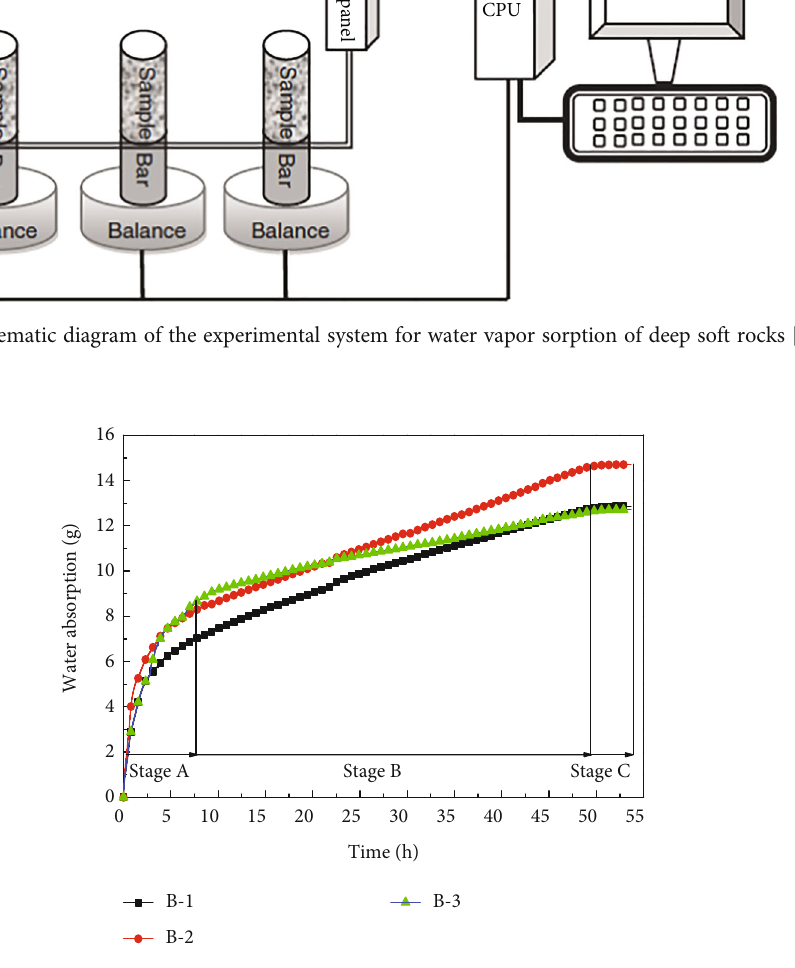
Figure 3: Time-water absorption variation curve.